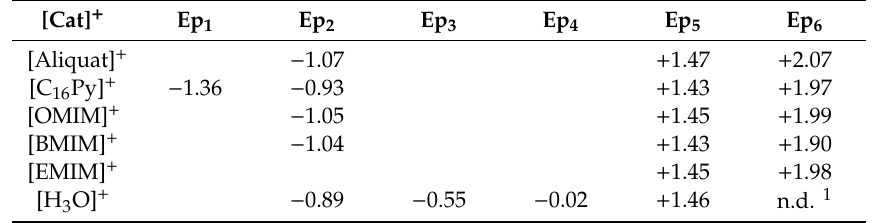
Table 1. Potential of oxidation and reduction (V) of the [Cat][MoO(O 2 ) 2 (pic)] compounds. [Cat] +